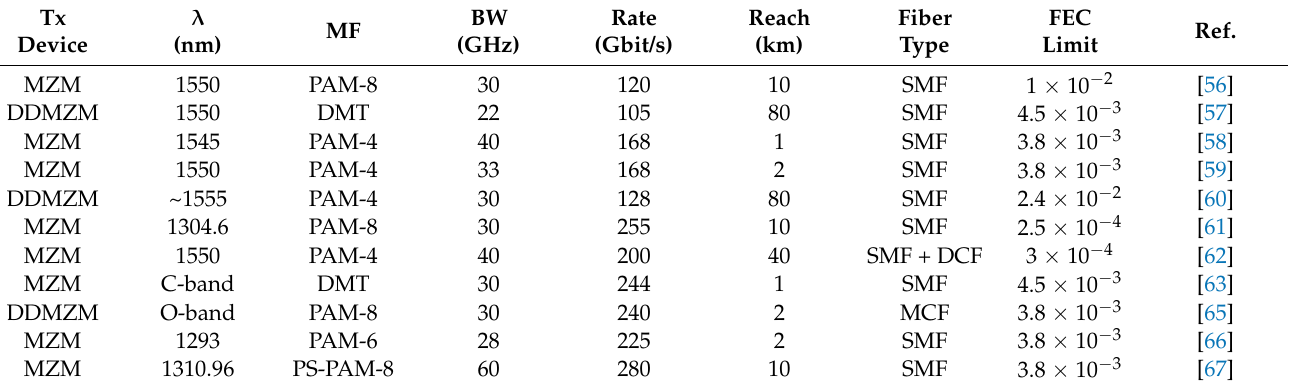
Table 3. Incomplete summary of MZM applied in beyond 100-Gbit/s per lane data